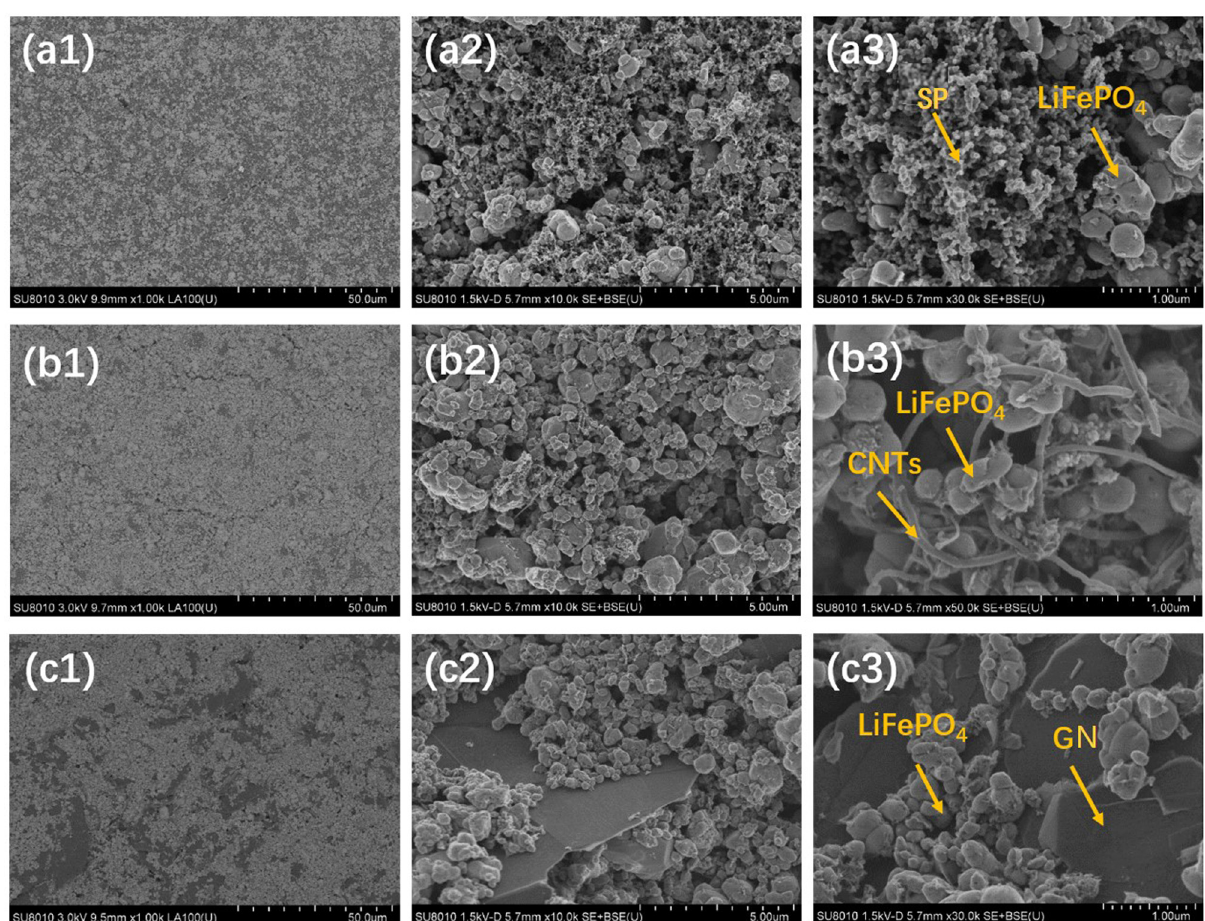
Figure 3: Surface SEM morphology of LiFePO 4 cathode plates with di ff erent unitary conductive agents ( a1 – a3: SP, b1 – b3: CNT, c1 – c3: GN )